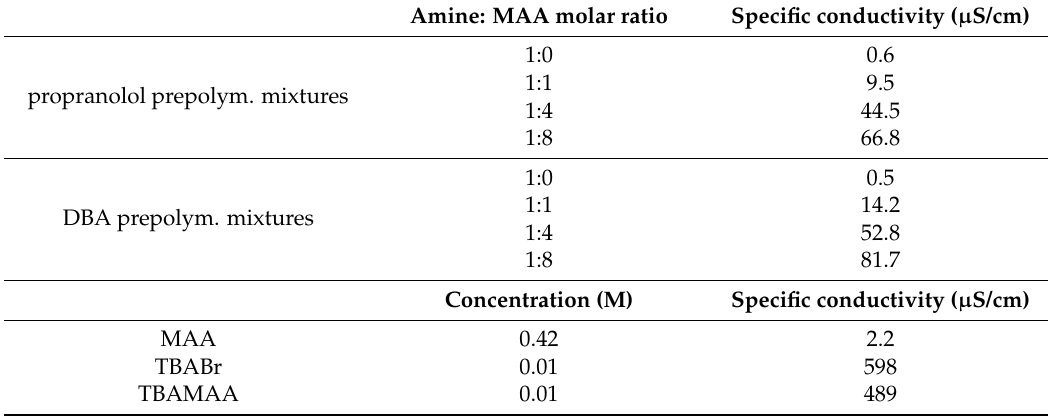
Table 1. The specific conductivities of different pre-polymerization mixtures and control